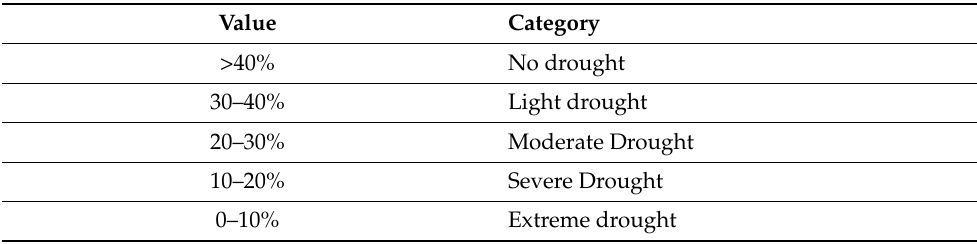
Table 3. Interpretation of the VCI, recommended practice by the United Nations, office for outer space affairs UN—Spider knowledge portal. (Recommended Practice: Drought monitoring using the Vegetation Condition Index (VCI): https://un-spider.org/book/export/html/9206, accessed